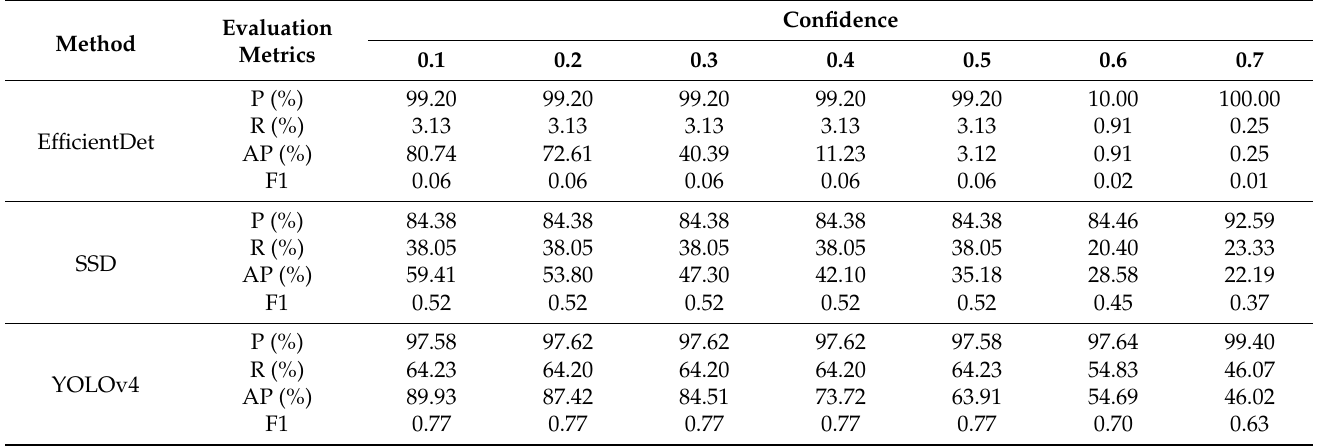
Figure 11. Statistical results of positive and negative sample numbers for each method with different confidence thresholds (the histogram in the figure corresponds to the number of positive samples, the line graph corresponds to the number of negative samples; blue, green, and orange correspond to the three methods, EfficientDet, SSD, and YOLOv4, respectively). Table 4. Performance evaluation results of each method with different confidence